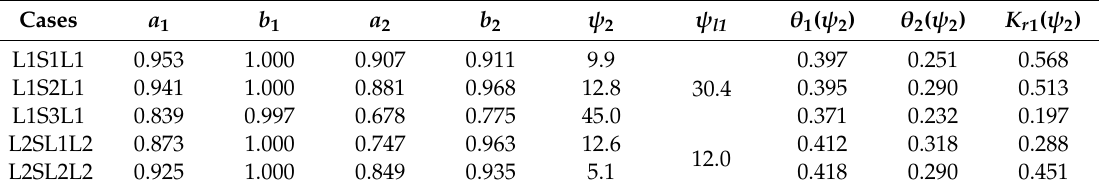
50 cm and the infiltration time is 300 min.